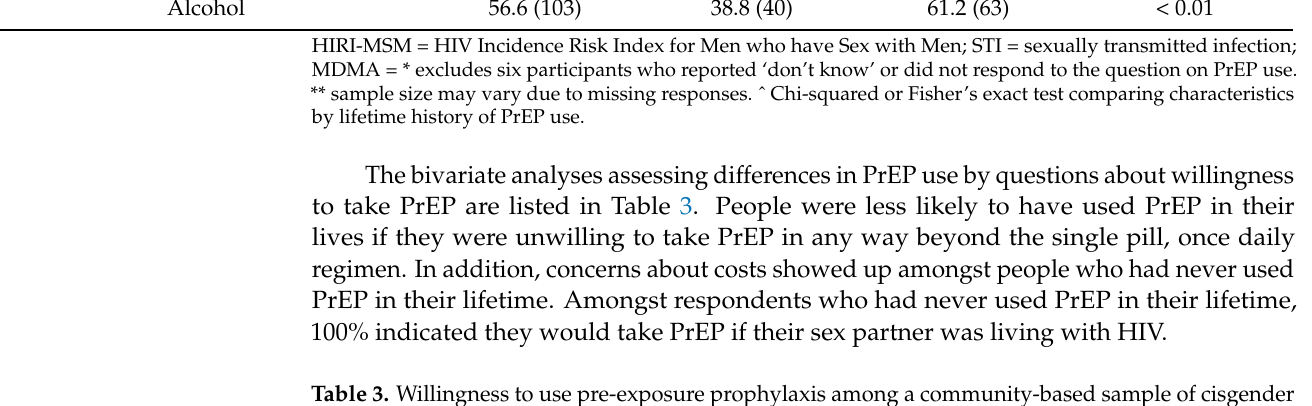
Table 3. Willingness to use pre-exposure prophylaxis among a community-based sample of cisgender men and transgender women who have sex with men residing on Long Island,